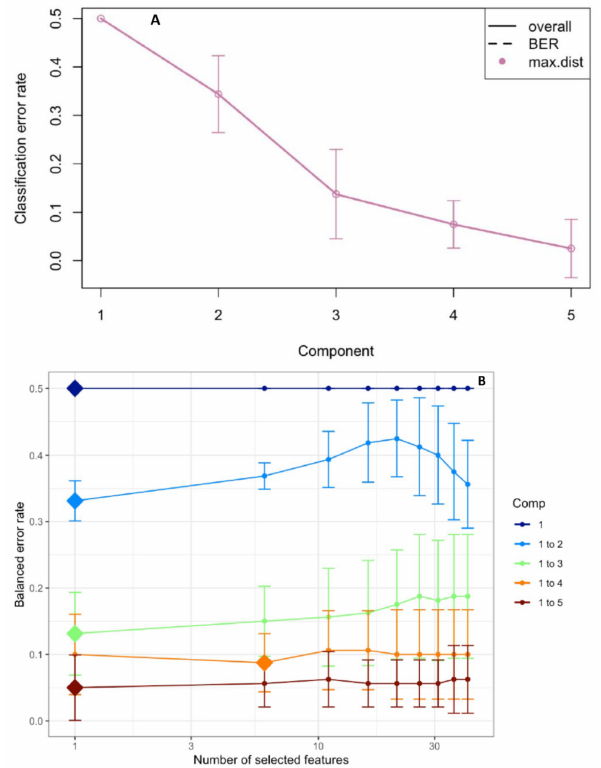
Figure 4. Choosing the number of components in the sparse Partial Least Squares-Discriminant Analysis (sPLS-DA) by the performance test ( A ). Mean classification by the overall and balanced error rate (BER) (5 cross-validations averaged 50 times) for each sPLS-DA component. Choosing the number of root traits for each sPLS-DA component by a tuning test ( B ). Estimated classification balanced error rates for the root morphology dataset (5 cross-validations averaged 50 times) with respect to the number of selected root traits for the sparse exploratory approaches.